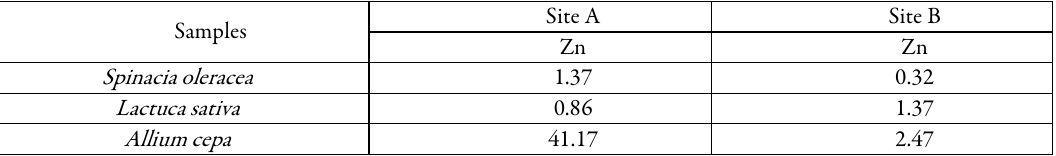
Table 4. Estimated bioaccumulation factor mg/kg